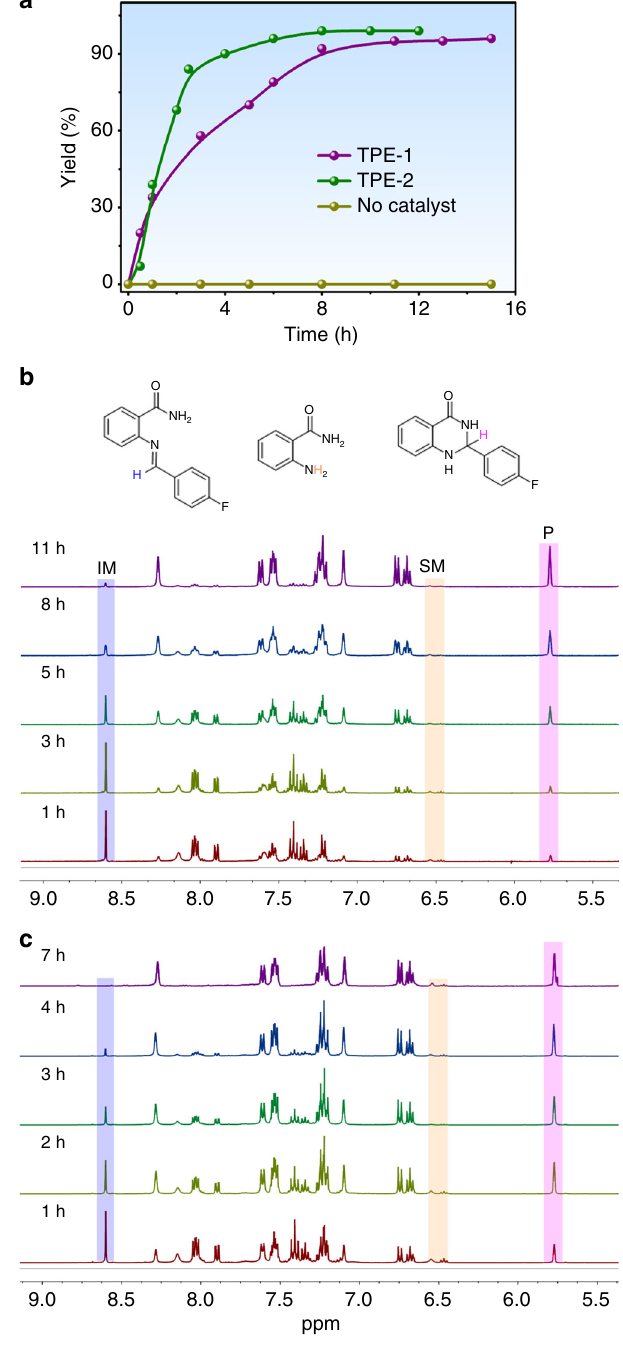
Fig. 3 Kinetic results of the catalysis. a Kinetic curves obtained with 0.1 mol % of the cage and without catalyst in the sequential condensation and cyclization of 3a and 4b ; b , c evolution of 1 H NMR spectra during the reaction for TPE -1 and TPE -2 [SM = starting material ( 3a ); IM = intermediate ( 5b ); P = product ( 6b )]